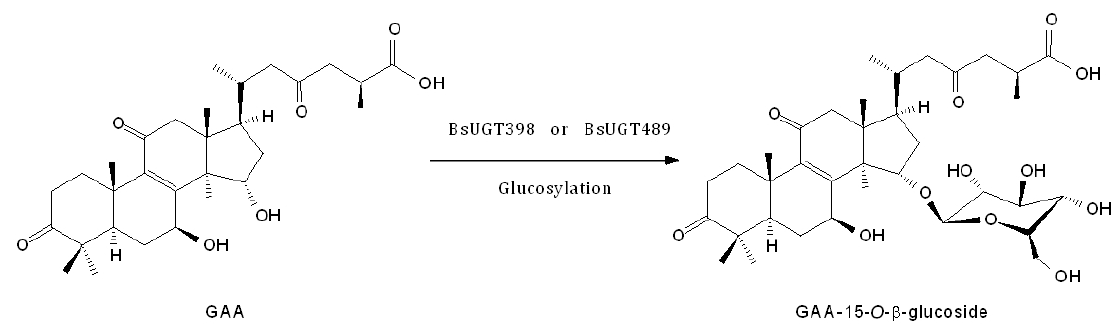
Figure 5. Biotransformation process of GAA by BsUGT398 or BsUGT489.